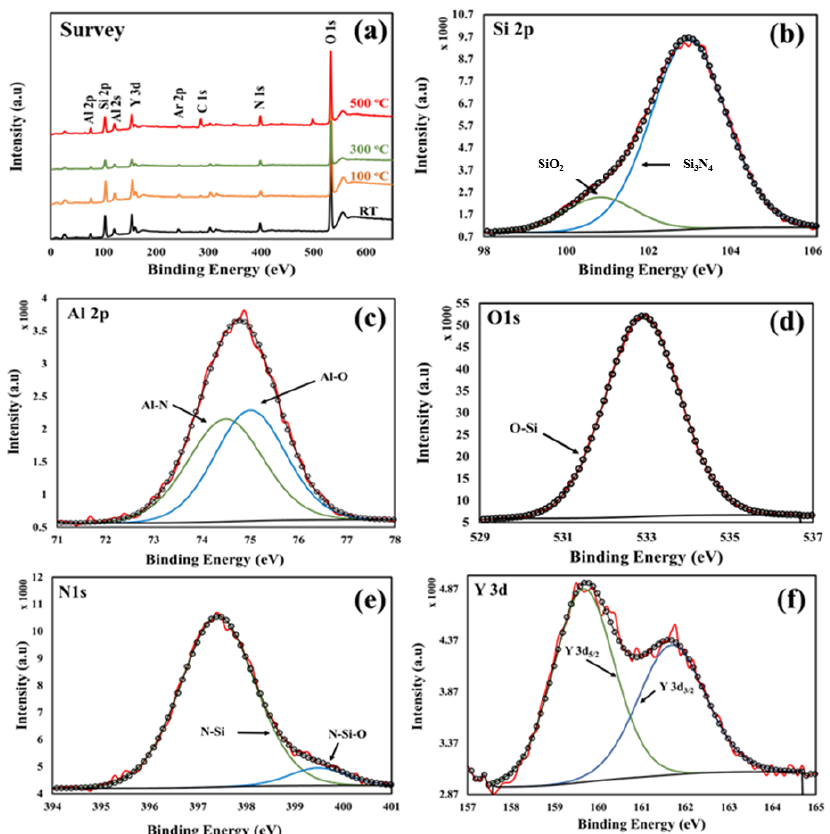
Figure 7. ( a ) XPS survey of the Y/Sialon thin films prepared using PLD at various deposition temperatures; ( b – f ) high resolution scan of Si2p, A12p, O1s, N1s, and Y3d, respectively. Table 3. XPS analysis of the Y/Sialon thin films prepared using PLD technique at evaluated substrate temperatures.